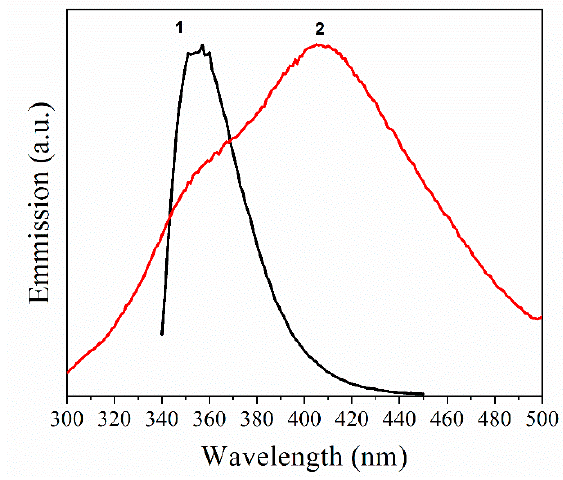
Figure 8. Normalized fluorescence spectra of (1) Naproxen (NAP) solution; (2) suspension of NL004, excitation wavelength (259 nm).